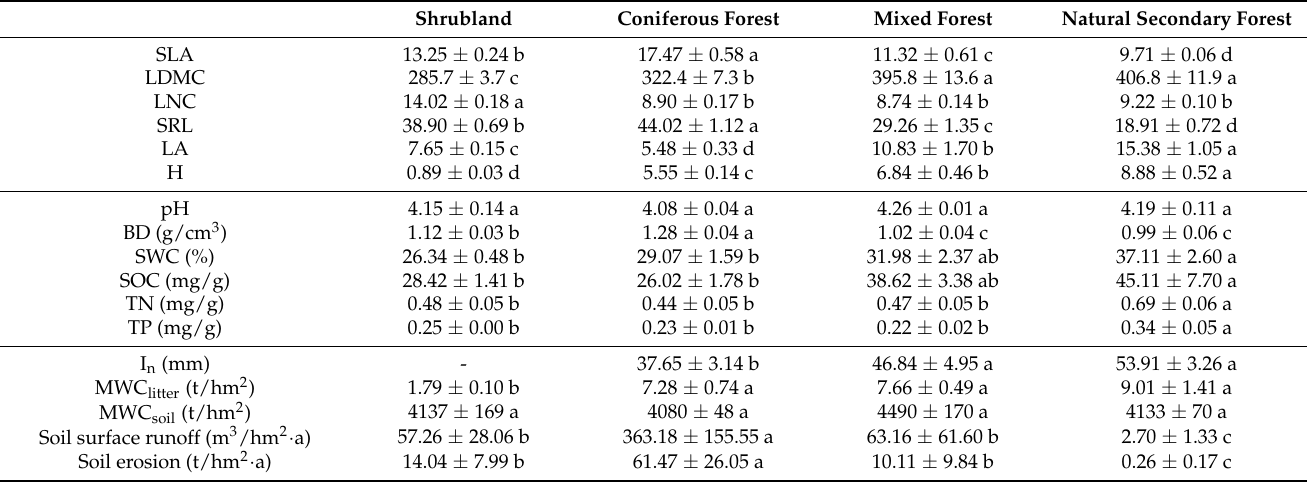
Table 1. Plant traits, soil physicochemical properties, and water and soil conservation capacity in four land restoration types.